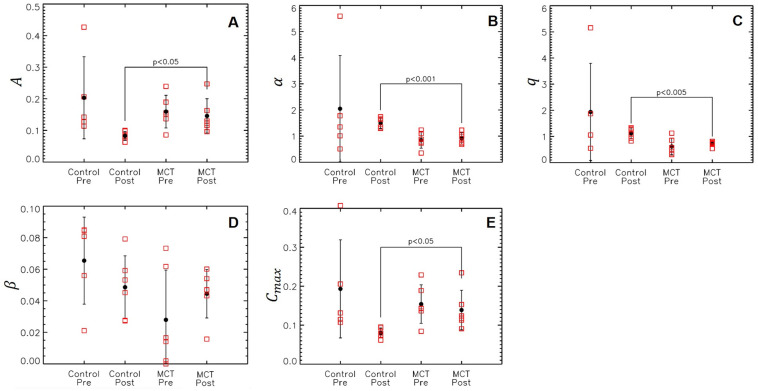
DCE empirical mathematical model parameters A (A), alpha (B), q (C), β (D) and Cmax (E) in treated and untreated mice.Significance between the two groups and p values shown accordingly.